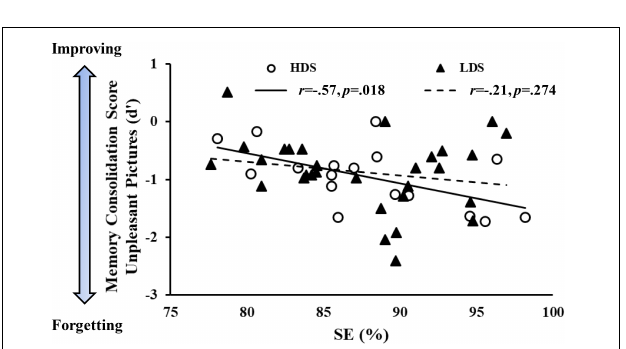
FIGURE 8 | Memory consolidation score ( d ’ of the delayed minus d ’ of the immediate recognition session) of the unpleasant pictures as a function of sleep efficiency (SE) in the two